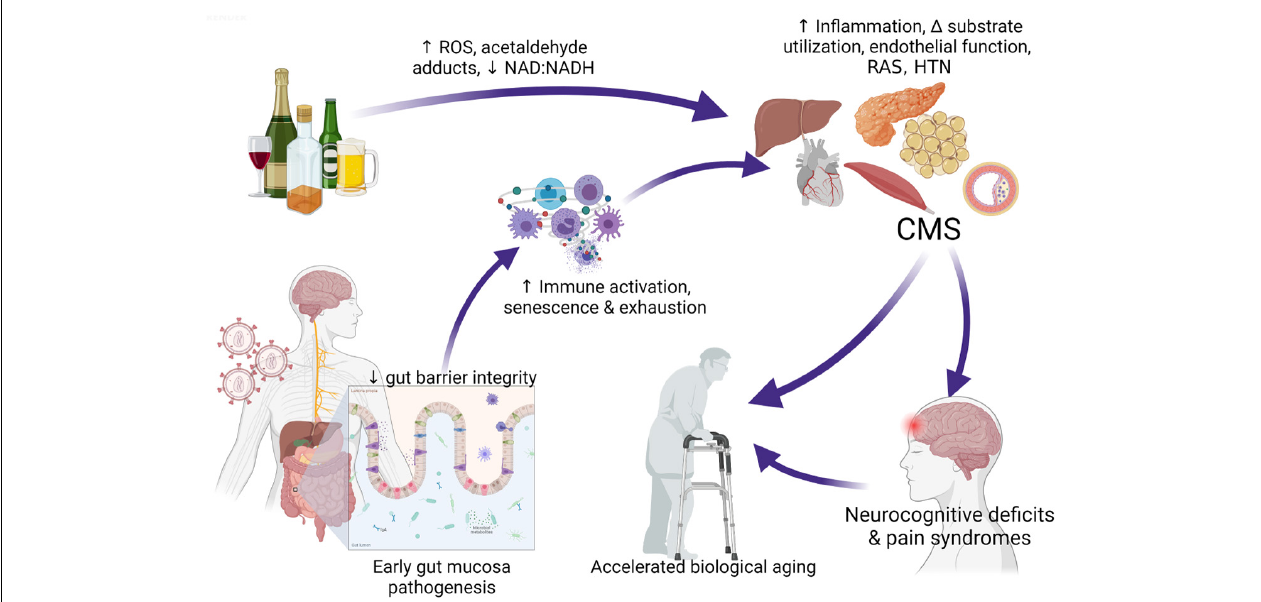
FIGURE 1 | Interaction of at-risk alcohol use and HIV infection. Chronic stressors including unhealthy alcohol consumption and HIV infection affect several biological processes and synergize with gut immunopathological effects of alcohol, decreasing gut mucosal barrier integrity, promoting dysbiosis, and gut bacteria and toxin leak. Alcohol metabolism generates toxic by-products that, in turn, can promote tissue and cell injury. Pathophysiological processes frequently linked to alcohol metabolism including oxidative stress, mitochondrial injury, altered growth factor signaling, nutritional deficits, and epigenetic modifications. These synergize with systemic immune activation, inflammation, and cell senescence and exhaustion driven by gut leak, enhancing tissue injury and dysregulation of homeostatic mechanisms increasing risk for cardiometabolic syndrome (CMS). The cluster of target organ dyshomeostasis associated with CMS is associated with increased risk for neurocognitive deficits and pain syndromes that can exacerbate or accelerate biological aging. ROS, reactive oxygen species; RAS, renin angiotensin system; HTN, hypertension; CMS, cardiometabolic syndrome. Created with